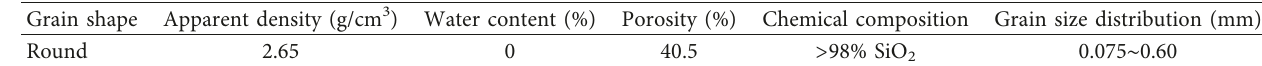
Table 3: Physical properties of the sand used in this study [13].